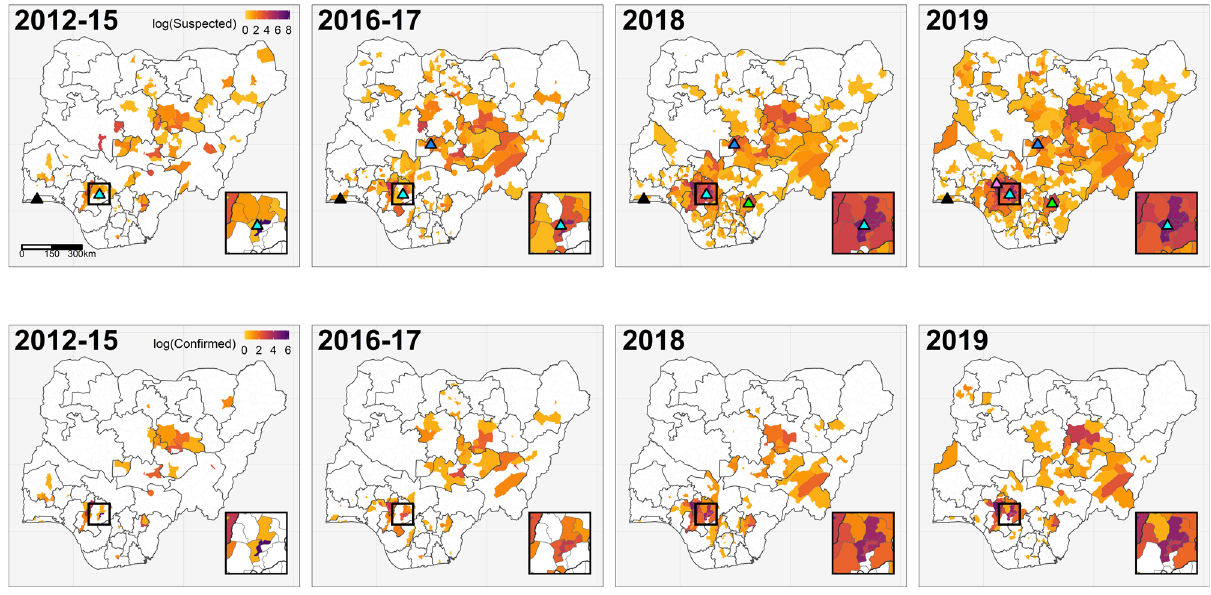
Fig. 2 Spatiotemporal trends in Lassa fever surveillance, con fi rmed cases, and diagnostic laboratory capacity across Nigeria. Maps show, on the natural log scale, the total reported Lassa fever cases (suspected and con fi rmed; top row) and laboratory-con fi rmed cases only (bottom row) in each local government authority during the speci fi ed year(s). Triangles in the top row show the locations of laboratories with Lassa fever diagnostic capacity. Irrua Specialist Teaching Hospital (Edo, established 2008; inset box, pale blue) and Lagos University Teaching Hospital (Lagos, southwest; black) were both operational since before 2012. Three further laboratories became operational during the study period: Abuja National Reference Laboratory in 2017 (FCT Abuja, north-central; dark blue), Federal Teaching Hospital Abakaliki in 2018 (Ebonyi, southeast; green), and Federal Medical Centre Owo in 2019 (Ondo, south,